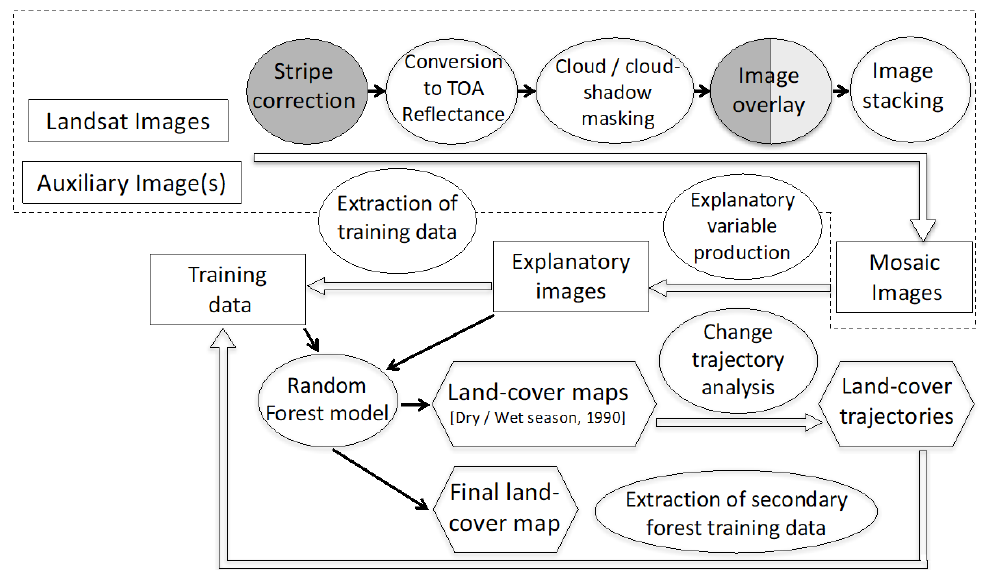
Figure 2. Flow chart of image pre-processing and classification processing steps. Squares denote images and training data, circles image processing steps, and hexagons land cover or land cover-derived products. White indicates steps involving all Landsat images (TM, ETM and OLI), dark gray represents steps involving only ETM images, and light gray show steps involving only OLI images. The dashed box denotes image collection and preparation, areas outside the dashed box classification and change trajectory models.